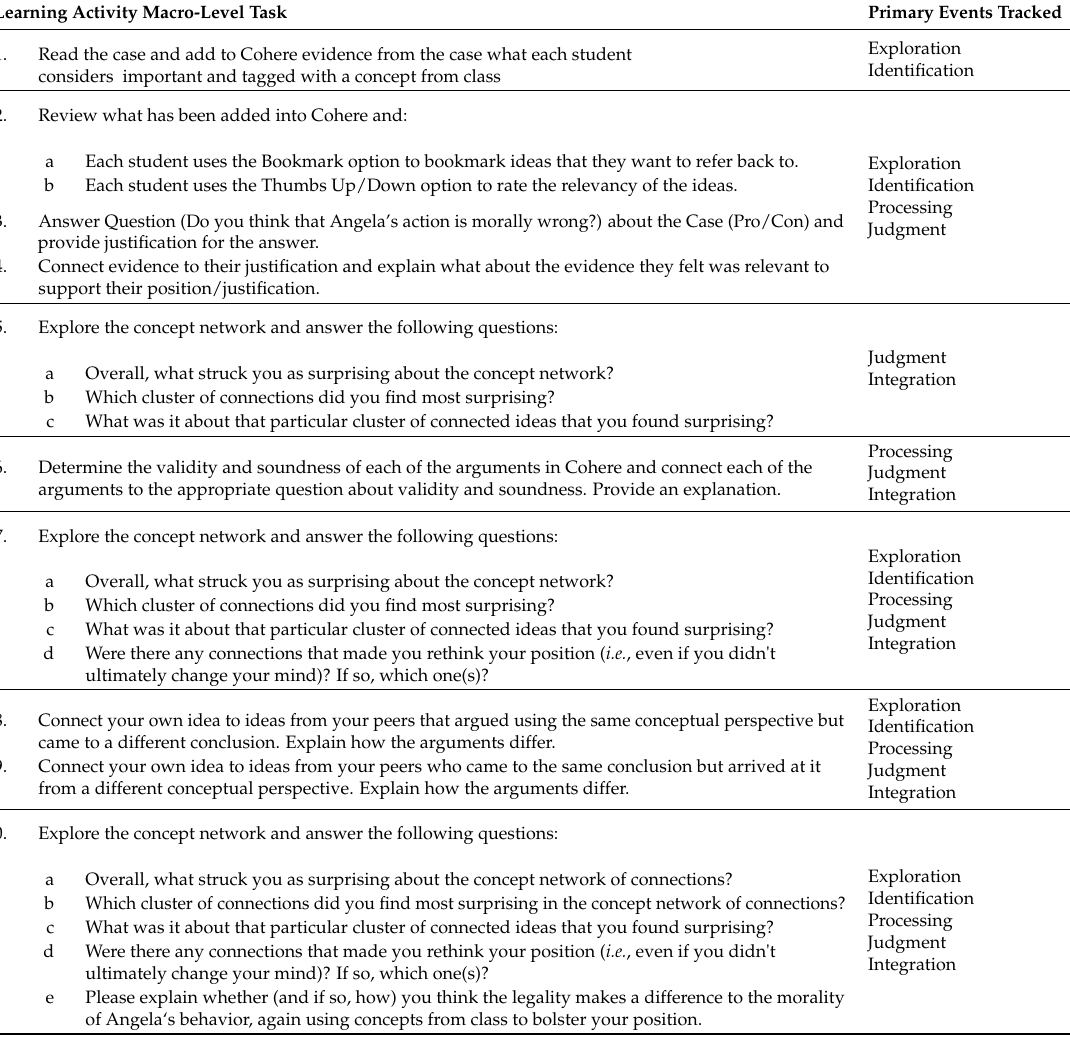
Table 1. Macro-level mapping of task to